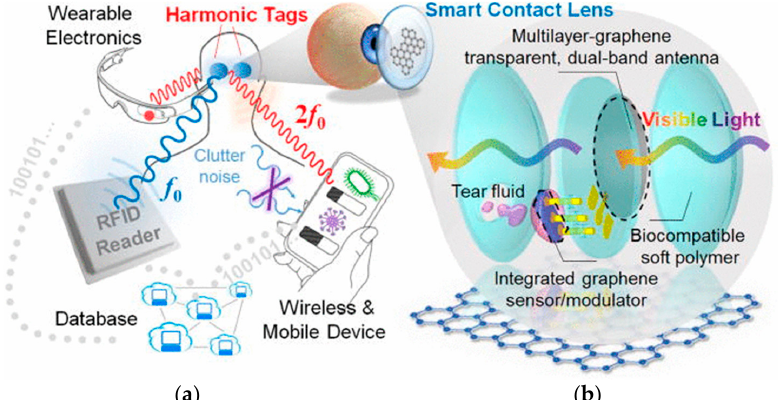
Figure 6. A graphene-based harmonic sensor on a soft contact lens. ( a ) Schematics of a fully passive, transparent, and conformal all-graphene harmonic sensor designed for various point-of-care monitoring and wireless biosensing and ( b ) an eye-wearable device (smart contact lens) based on the all-graphene harmonic sensor (reprinted with permission from [70]).